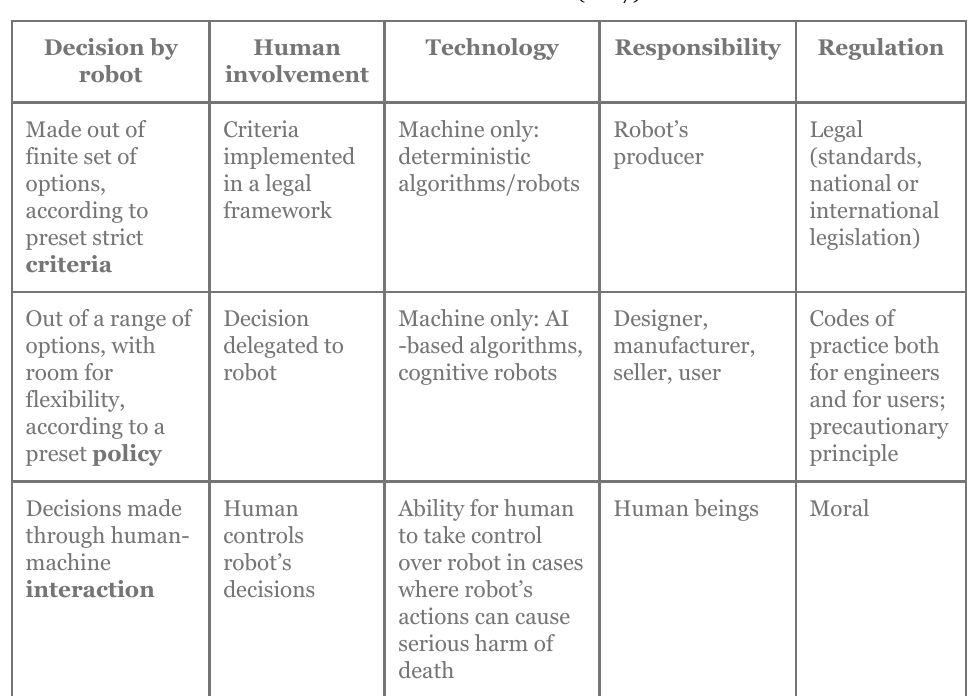
Table 1. From UNESCO